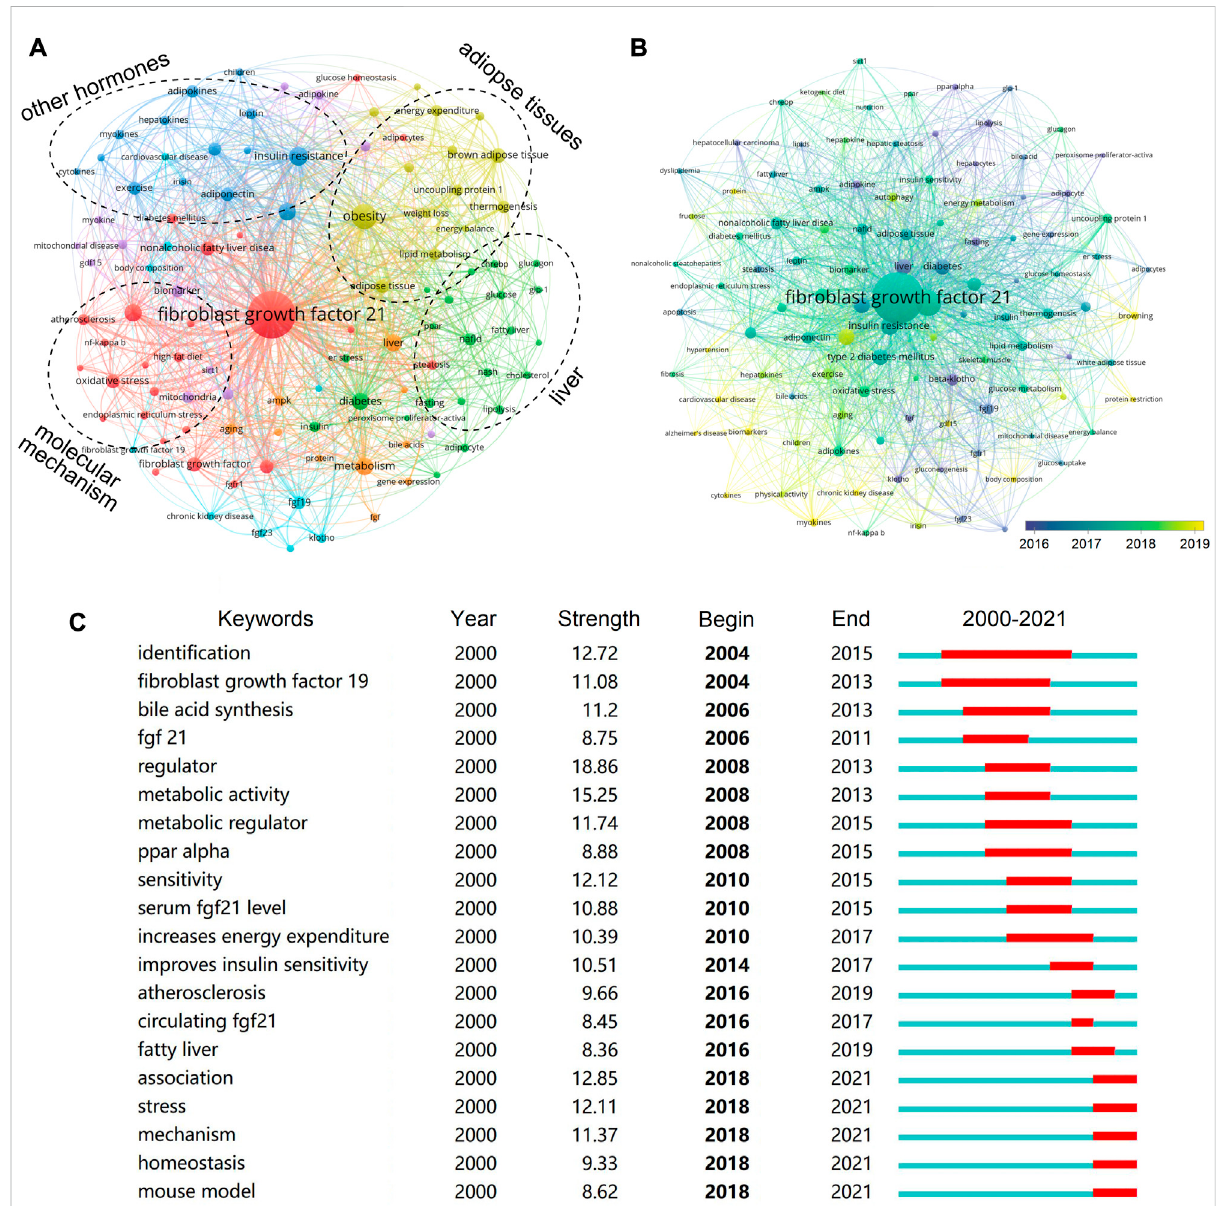
FIGURE 6 Analysis ofkeywordsinpublications. (A) Clusteringofco-occurrencesamongkeywords.Keywordswith closerelationshipsareassignedtoone cluster with the same color, and these keywords are roughly divided into four clusters: the association between FGF-21 and other hormones, the action of FGF-21 on adipose tissue, the action of FGF-21 on liver, and the molecular mechanisms of FGF-21. (B) Timeline visualization of co- occurrence among keywords. The nodes marked with purple color represent thekeywordsthat appeared relatively earlier, whereas those with yellow color represent the current research focuses. (C) Top 20 keywords with the highest citation